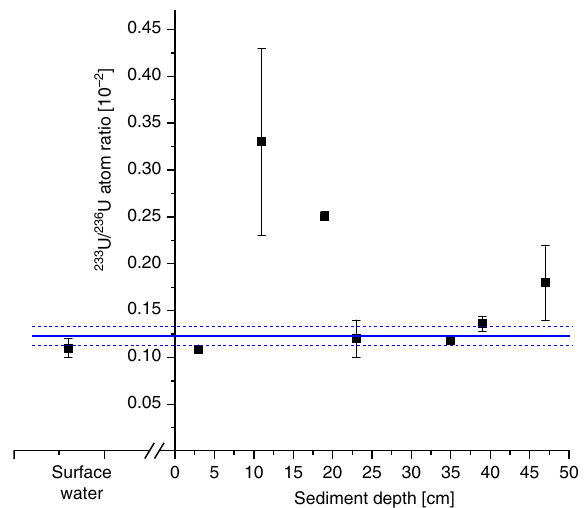
Fig. 4 233 U/ 236 U ratio in the Irish Sea. Depth pro fi le of the 233 U/ 236 U atom ratio in the Irish Sea sediment core collected close to the Sella fi eld reprocessing plant and in Irish Sea water (IAEA-381) with ±1 σ uncertainty. Increased uncertainties of three samples at depths 11 cm, 23 cm and 47 cm are caused by low counting statistics on 233 U due to preceding dilution (1:100) of the material. The horizontal blue line marks the weighted average for the 233 U/ 236 U ratio in the Irish Sea with ±1 σ uncertainty